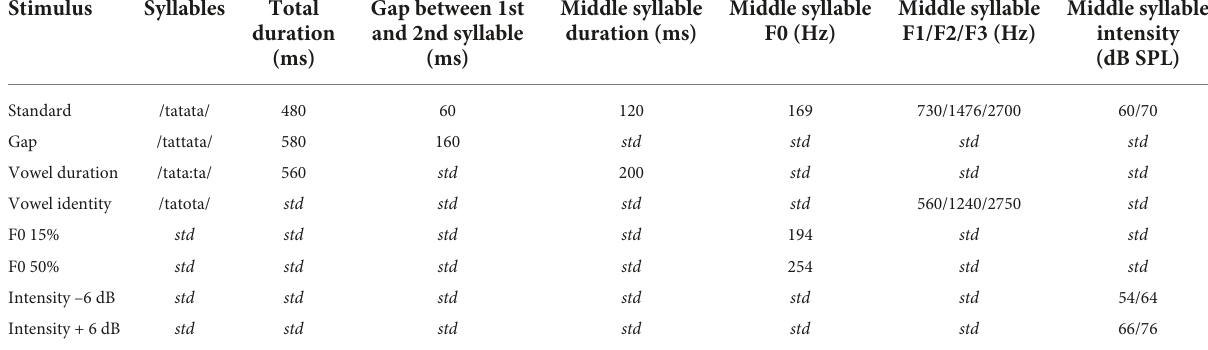
TABLE 2 Stimulus